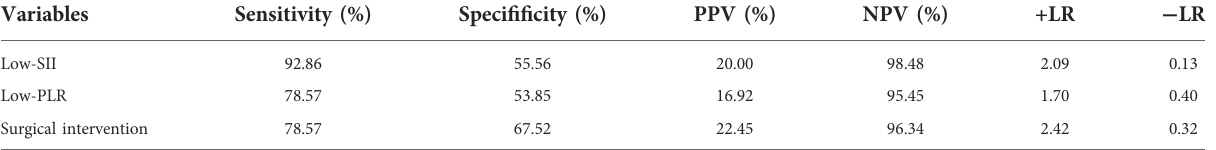
TABLE 6 Predictive value of Low-SII, Low-PLR and surgical intervention for mortality.